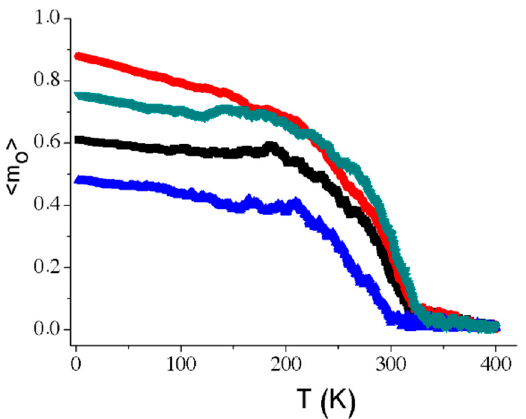
Figure 3. Meta-stability observed in the curves of magnetization as a function of temperature for a thickness of 24 muc.